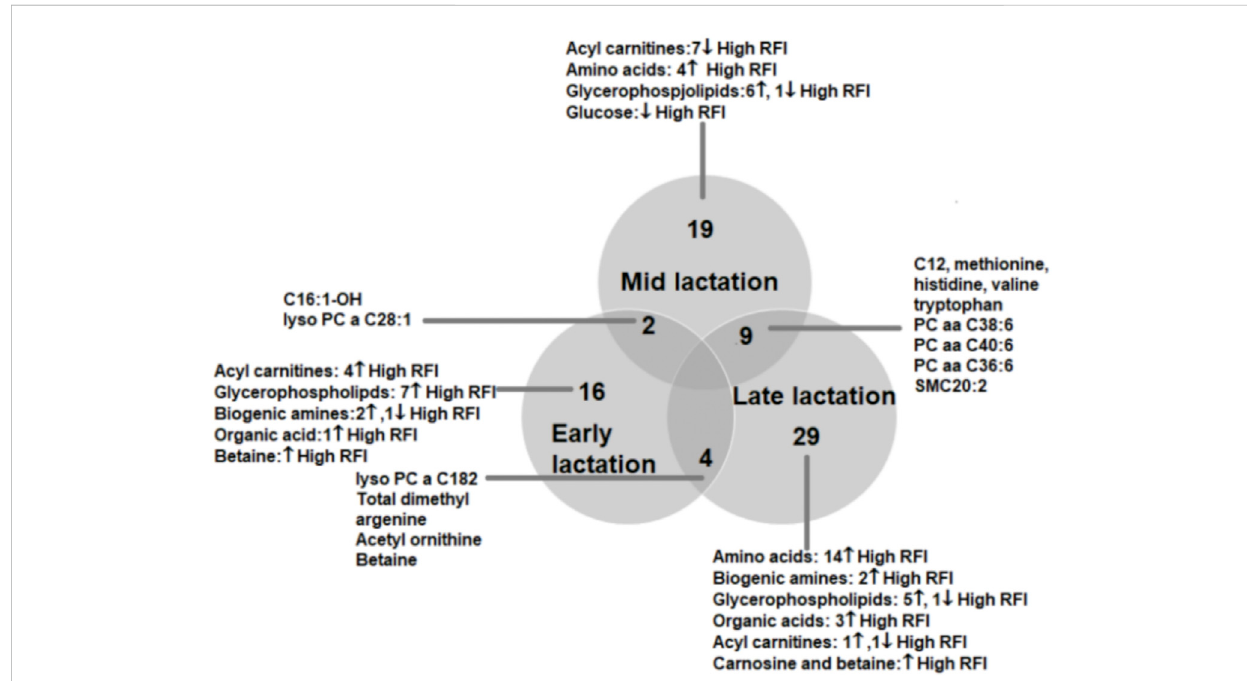
FIGURE 3 Venn diagram showing the number of metabolites altered between high and low RFI groups at early, mid and late lactation stages. The number of commonly altered metabolites between lactation stages are shown at the intersections of the circles representing the different lactation stages.